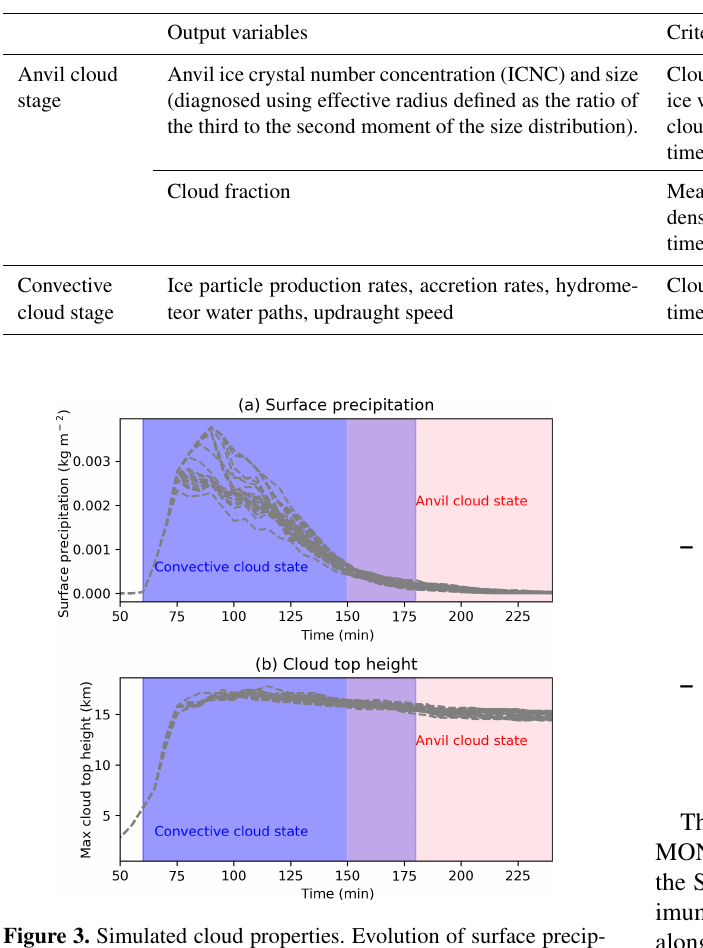
Table 1. Target output variables. List of target output variables discussed in this study and the criteria used to extract their values from the simulation output.